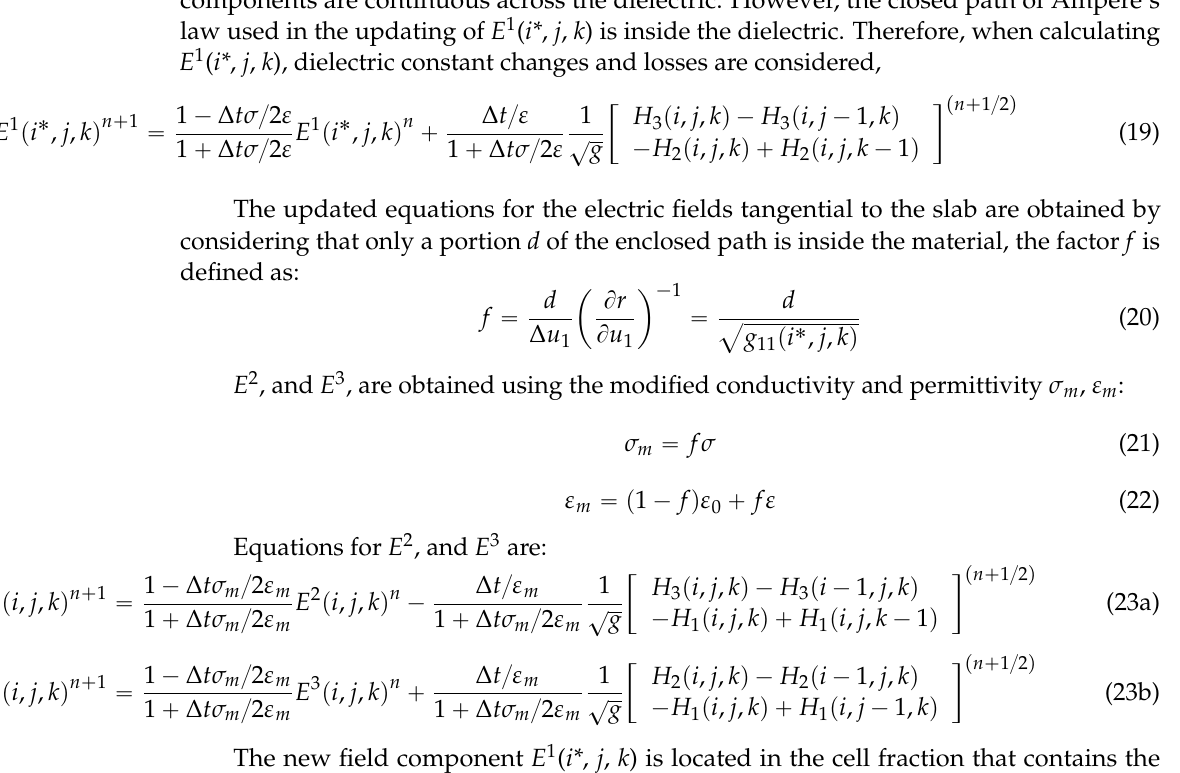
Equations for E 2 , and E 3 are: